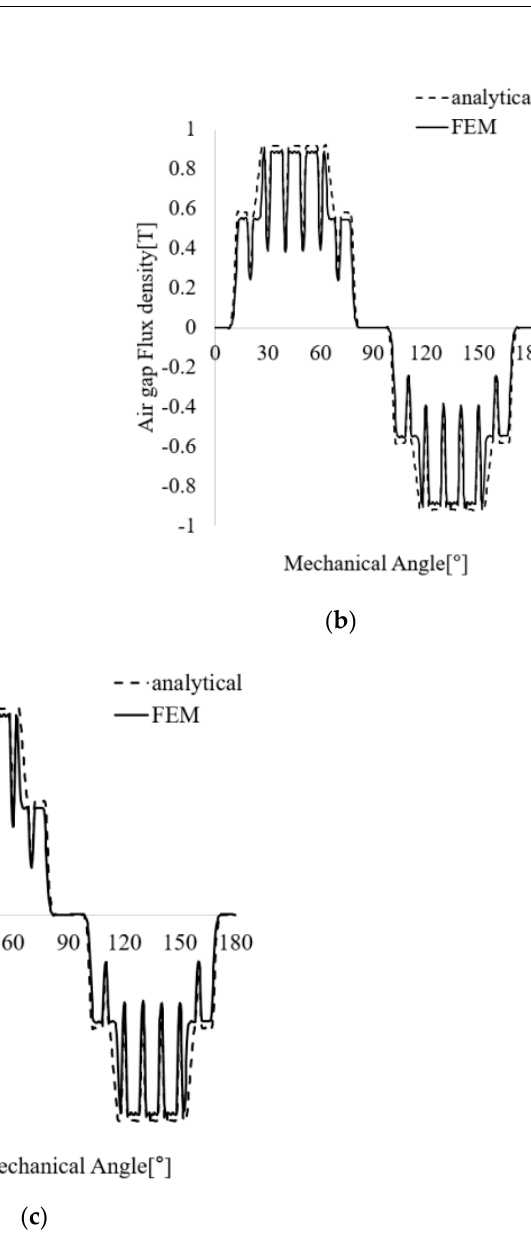
Figure 17. Comparison of flux density distribution when there is a slot for each two-layer shape derived through the HMEC and FEM: ( a ) DB, ( b ) DV, and ( c ) delta.